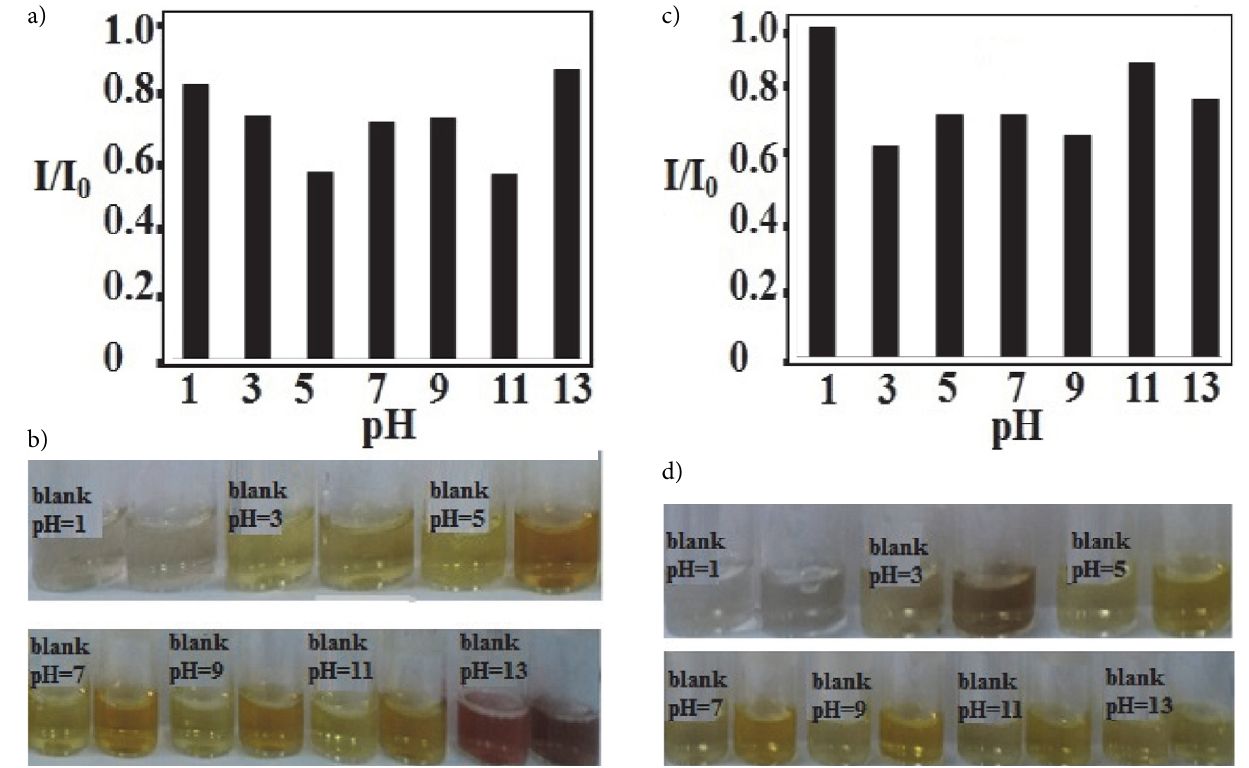
Figure 10. Bar graphs of UV-vis intensity changes and photographic images of (a and b) SDS-CD-AgNPs at different pH levels (c and d) SDS-CD- AgNPs at different pH